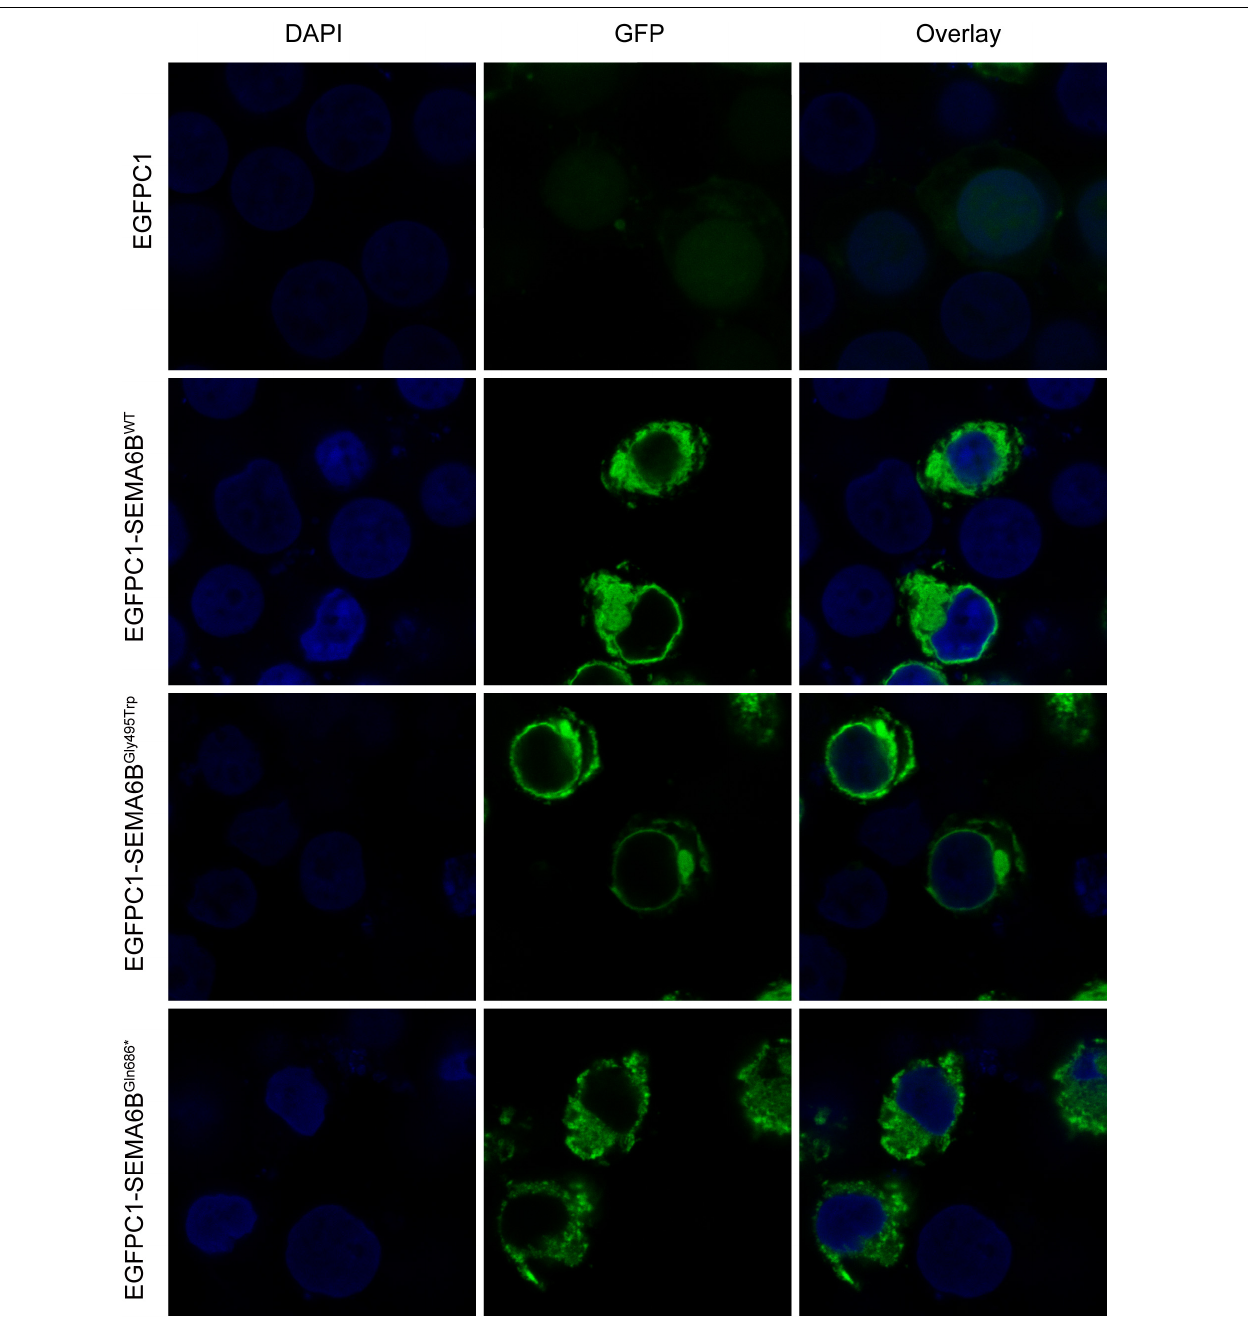
FIGURE 4 | Protein localization of wild type and mutant SEMA6B in plasma membrane and perinuclear membrane. Subcellular distribution of SEMA6B Gln686 ∗ failed to locate in plasma membrane.